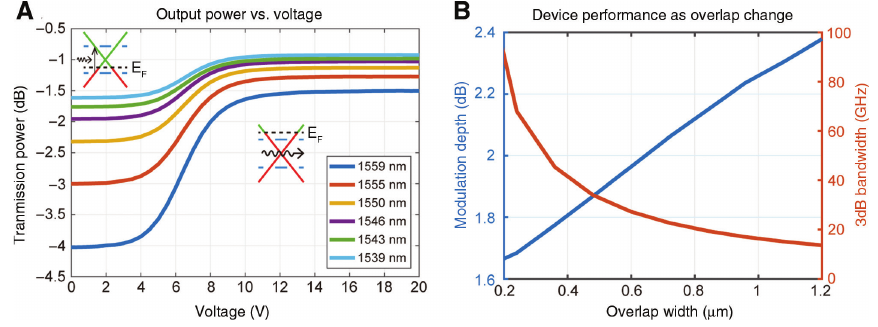
Figure 2: FDTD simulation of double-layer graphene modulator. (A) transmission power when applied with different bias voltages; (B) modulation depth and modulation bandwidth with double-layer graphene overlap width